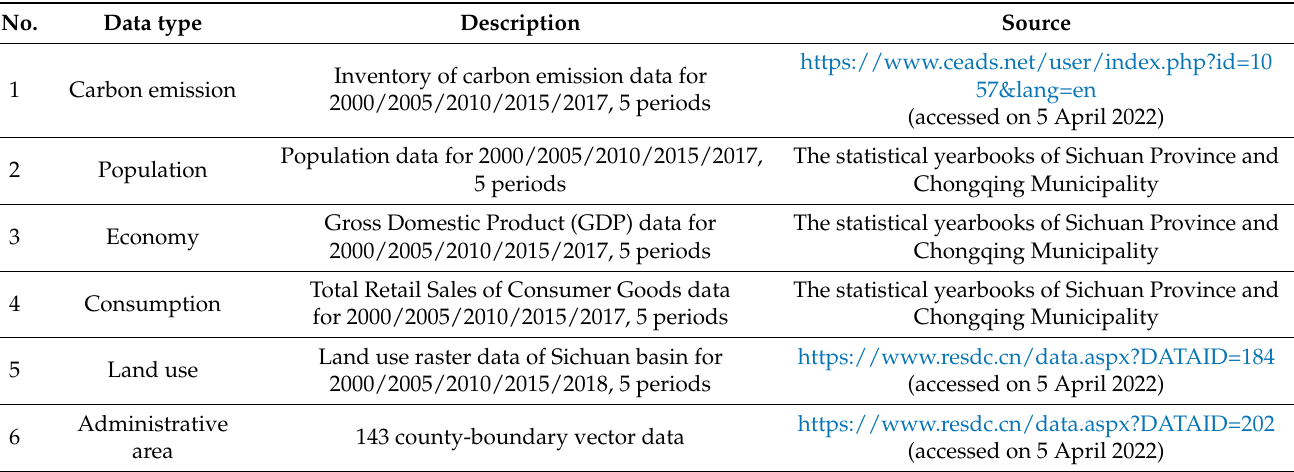
Table 1. List of data used in this